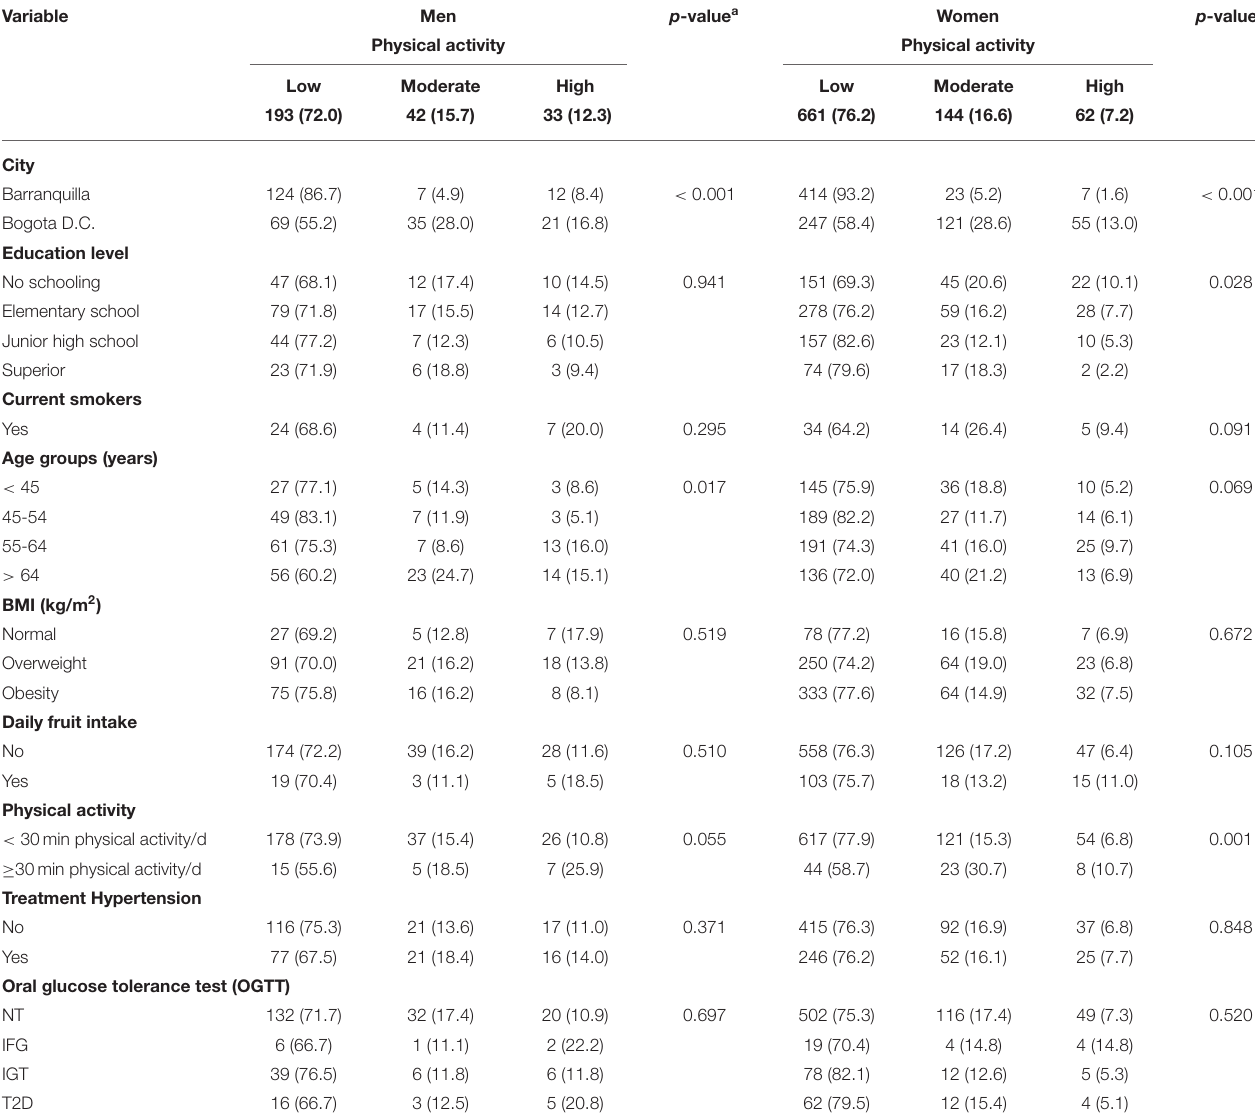
TABLE 1 | Baseline characteristics of the participants of PREDICOL according to their physical activity levels at baseline and sex. Variable Men p -value a